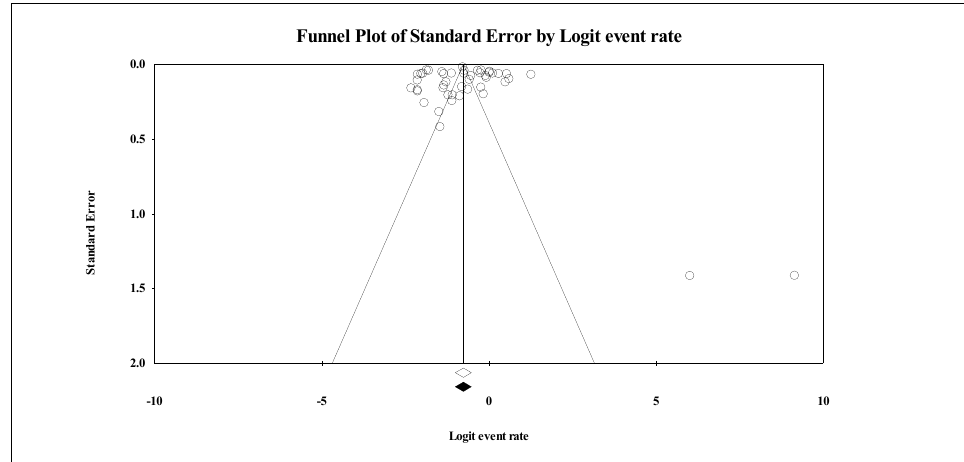
Figure A7. Funnel plot for studies on the prevalence of depression (Egger test: P = 0.90; Begg test: P = 0.64). The vertical solid line represents the summary effect estimates.